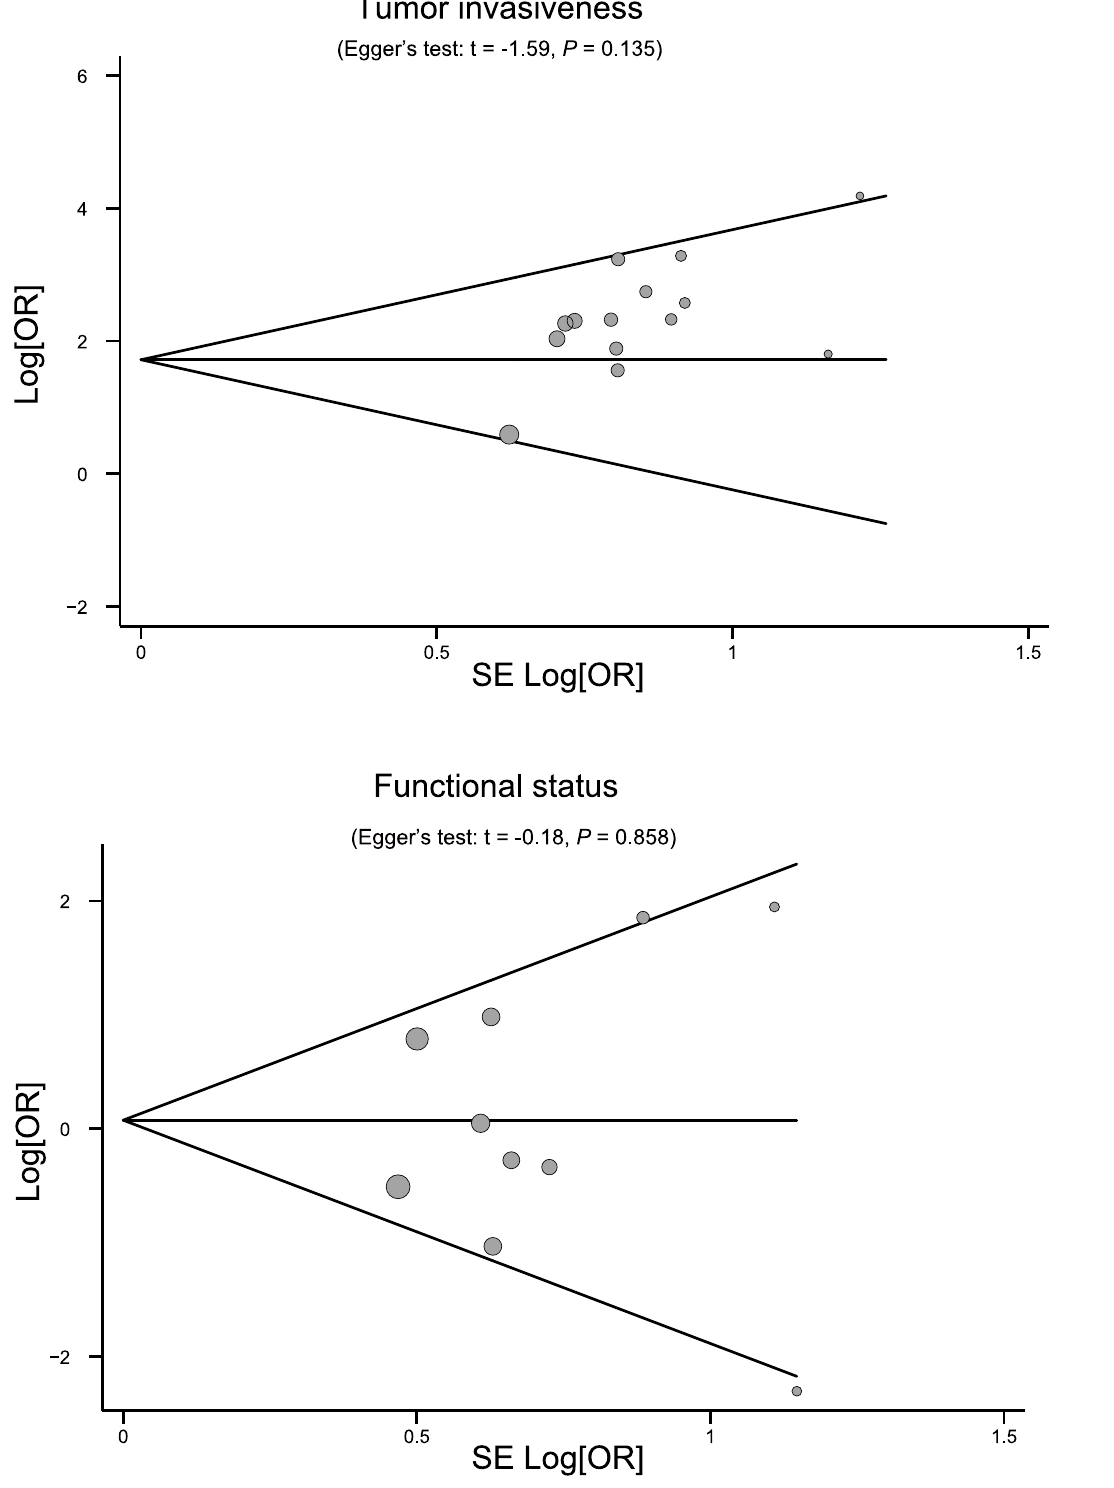
Figure 6. Sensitivity analysis of the association between PTTG expression and biological characteristics of pituitary adenomas. Results were computed by omitting each study in turn. Meta-analysis random-effects estimates (exponential form) were used. The two ends of the dotted lines represent the 95% CI.